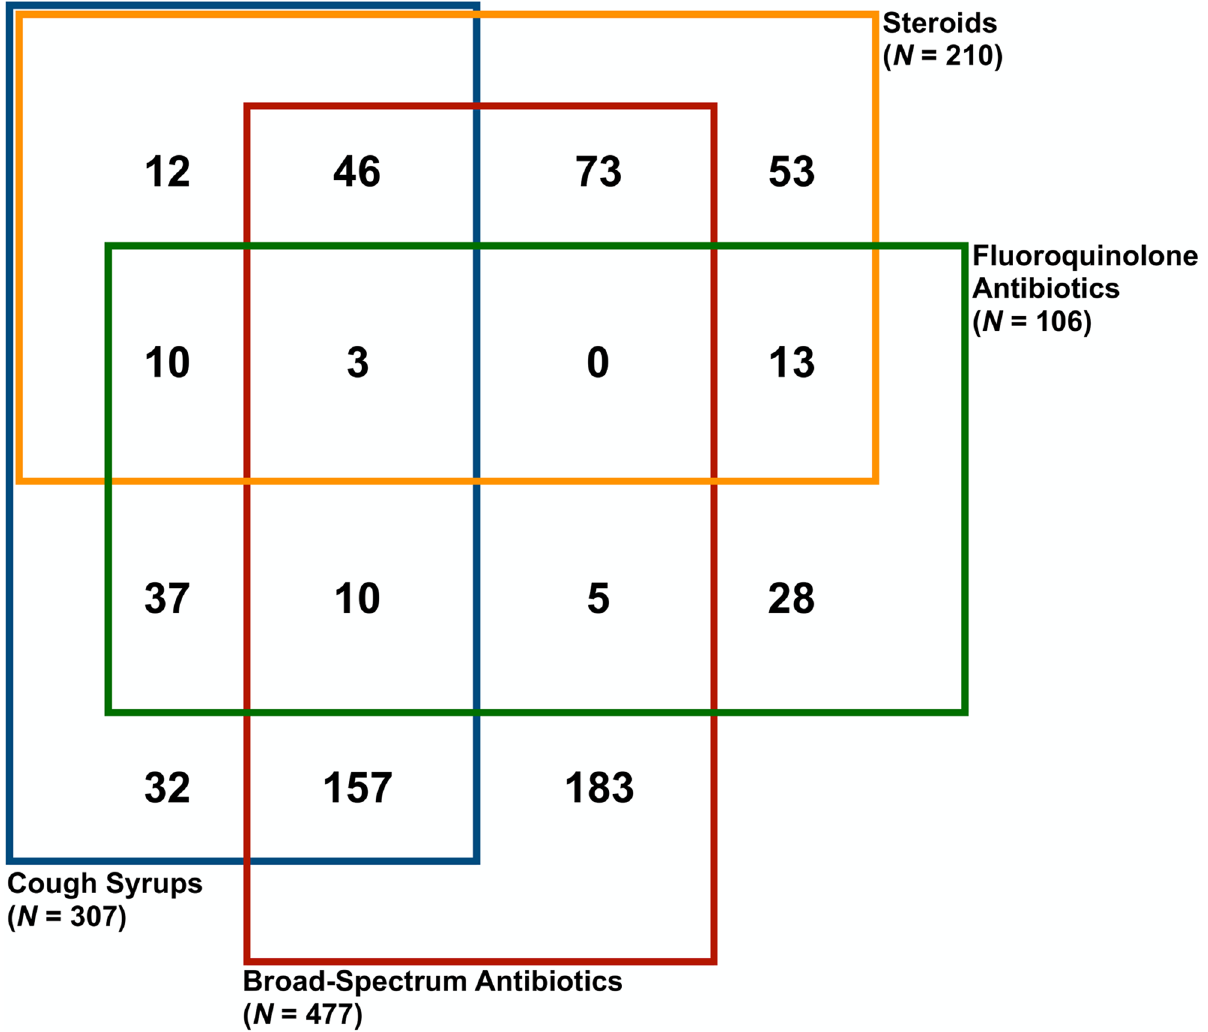
Fig 2. Management of Case 1 when no correct treatment was given. Frequency in which Case 1 was managed with possible combinations of steroids, cough syrups, broad-spectrum antibiotics, and FQs, when no correct management was given. There were N = 834 Case 1 interactions that did not meet the criteria for correct management, and 172 interactions resulted in none of these case management behaviors. FQ, fluoroquinolone.